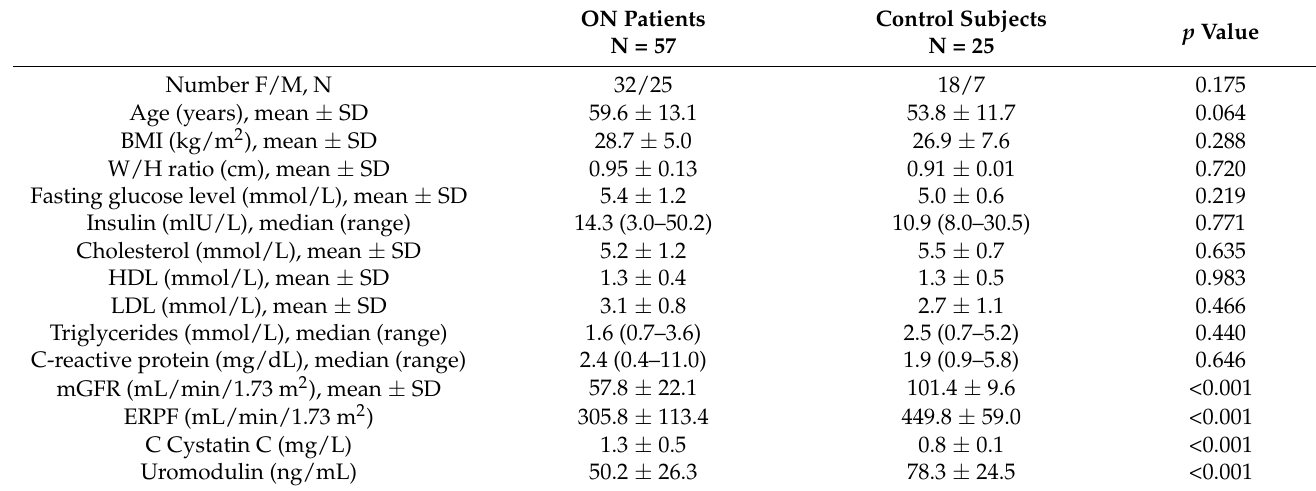
Table 1. Baseline characteristics of study